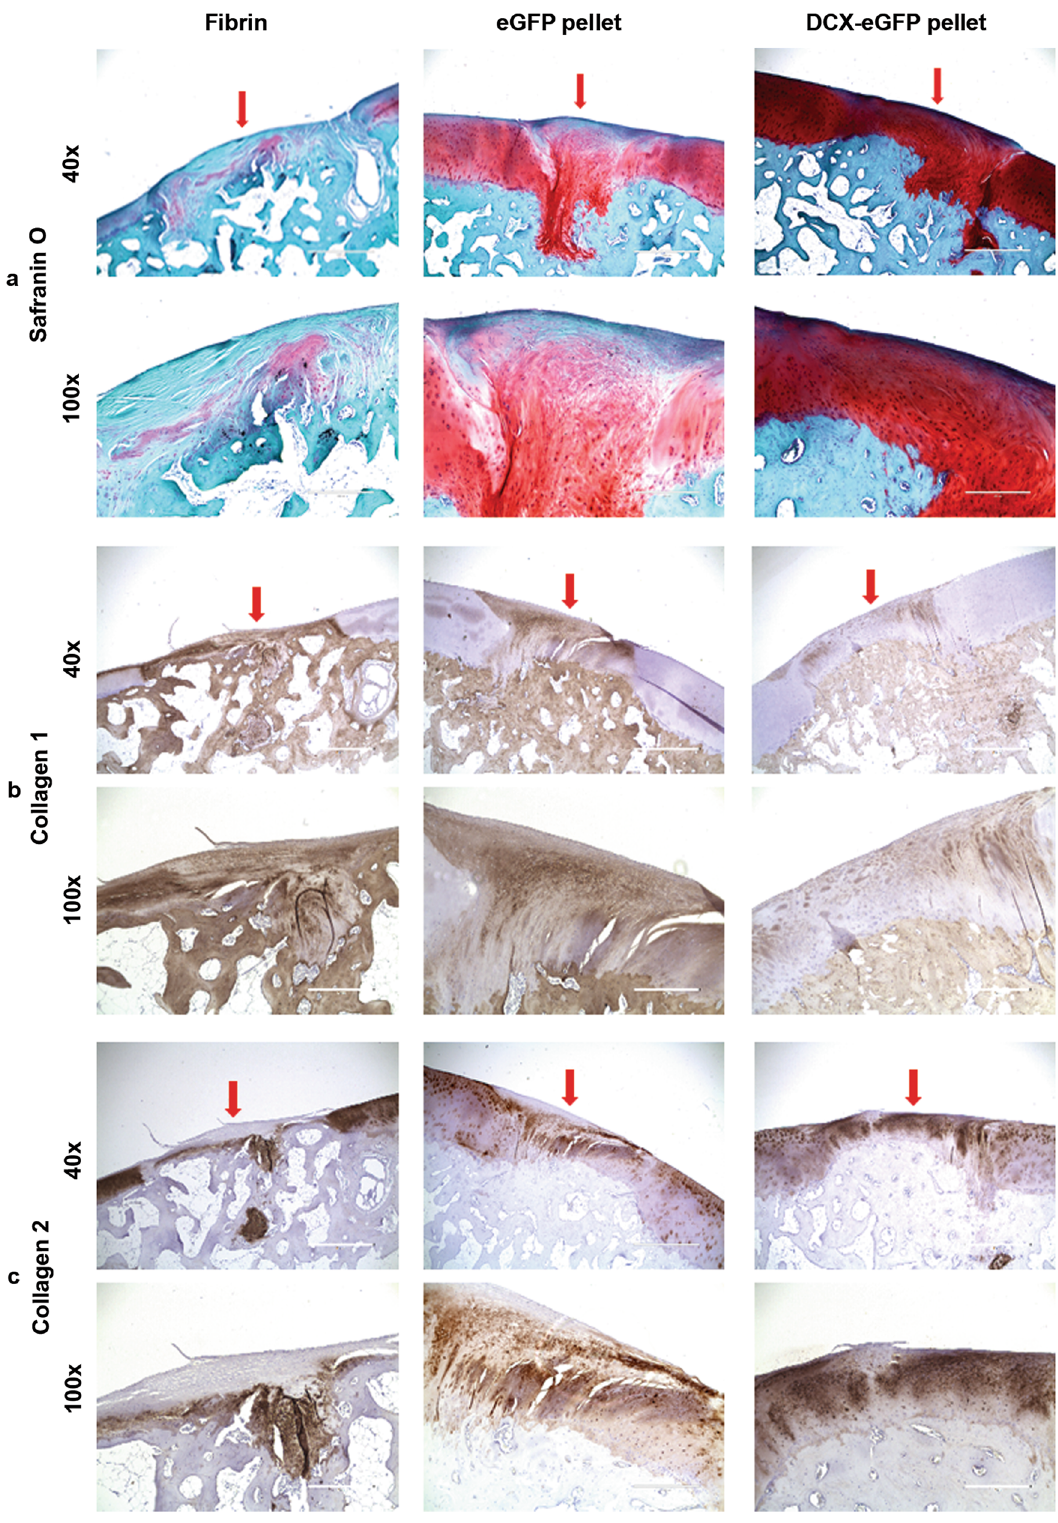
Fig. 7 Representative photomicrographs of monkey cartilage tissue sections at 24 months after surgery. a Safranin O staining. b Immunohistochemical staining of collagen 1. c Immunohistochemical staining of collagen 2. Arrows, the repaired cartilage defects. ×40 magni fi cation, scale bars = 1000 µm. ×100 magni fi cation, scale bars = 400